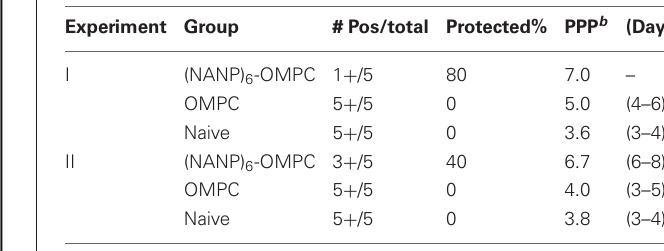
Table 1 | (NANP)6-OMPC immunized mice challenged by exposure to malaria-infected mosquitoes a